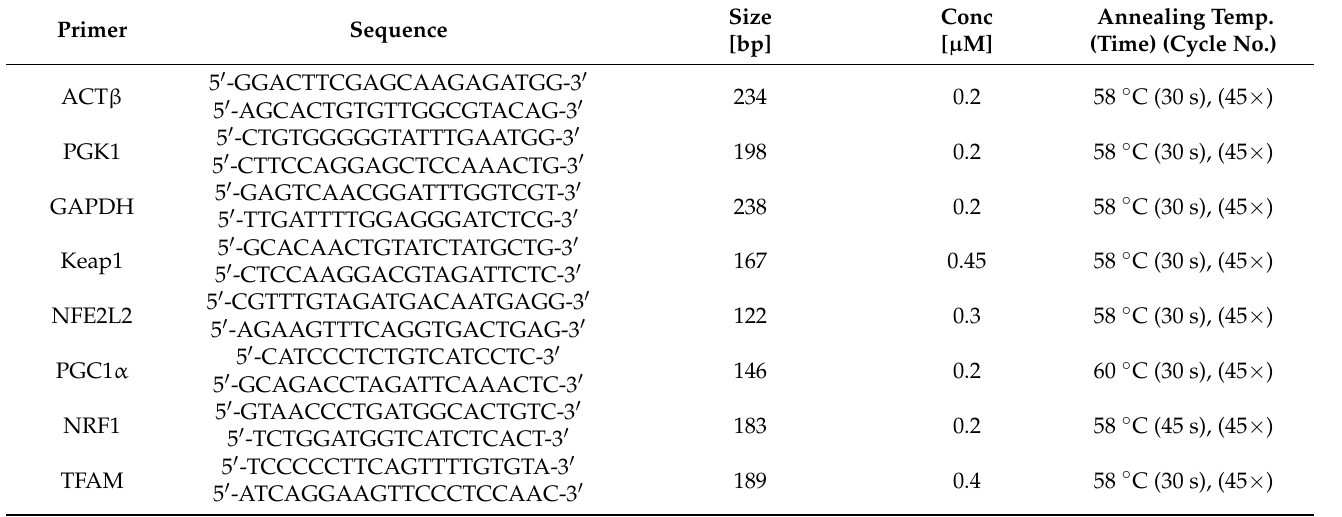
Table 1. Primer sequences, size of products, concentrations, and the protocols used for qRT-PCR measurement. Housekeeping genes were ACT β , PGK1, and